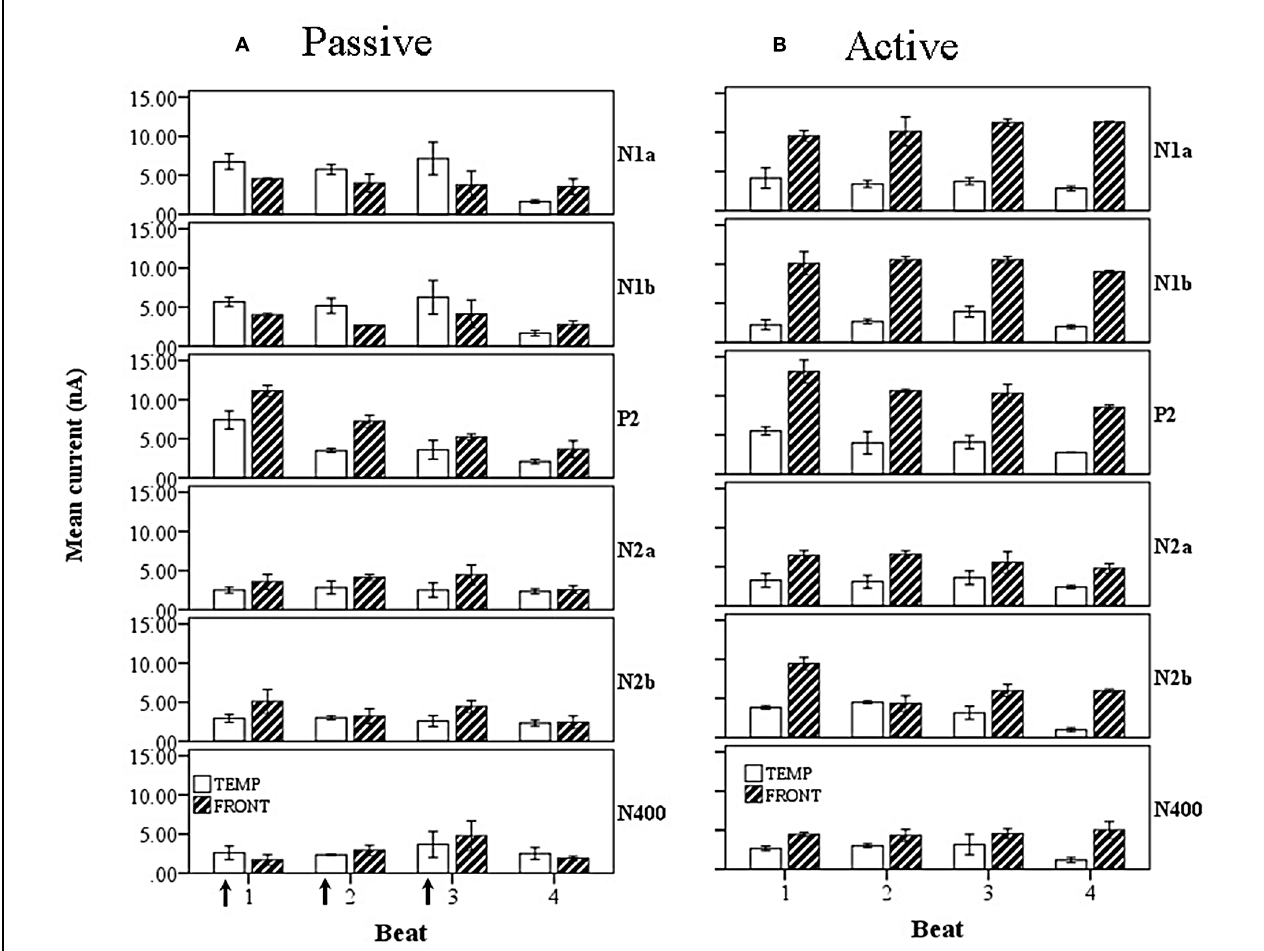
FIGURE 13 | Marginal means of source currents showing the effect of beat position for the mean of frontal and temporal lobe sources, broken down by wave, during (A) passive listening and (B) active synchronization. Error bars show SE. The arrows indicate the alignment of the